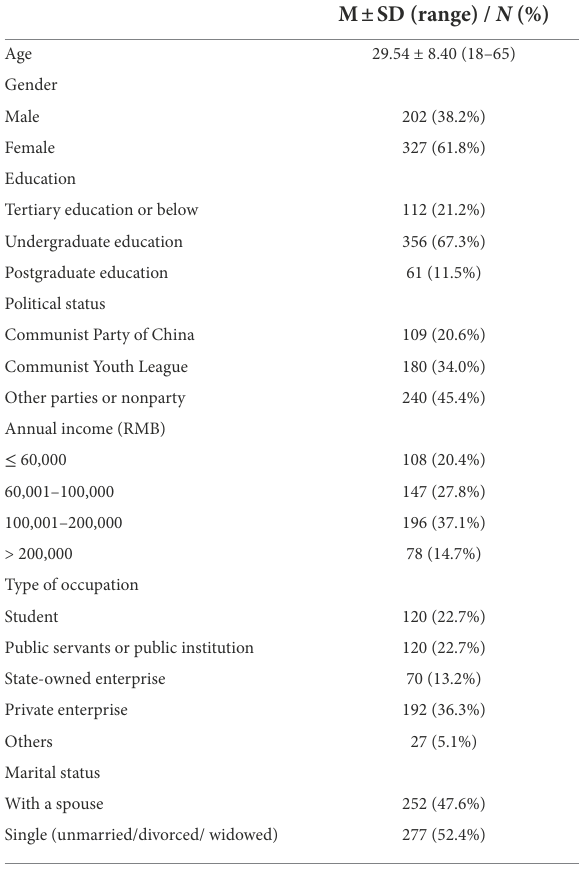
TABLE 1 Demographic information of